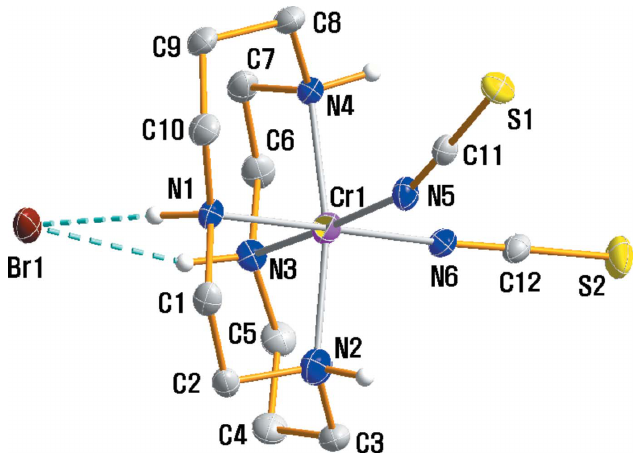
Figure 1 The molecular structure of (I), drawn with displacement ellipsoids at the 30% probability level. Only H atoms of amine groups are shown for clarity.